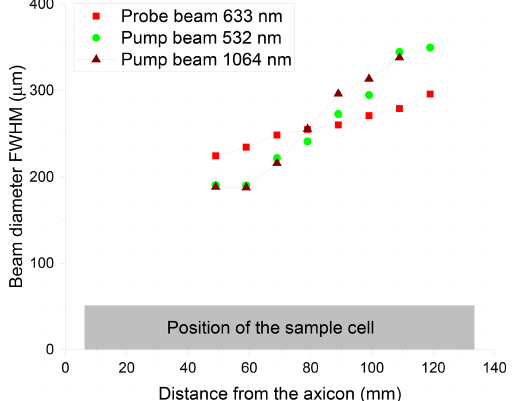
Figure 2. Beam diameters of probe and pump beams inside the sam- ple cell. Beam sizes closer to the axicon could not be measured due to mechanical